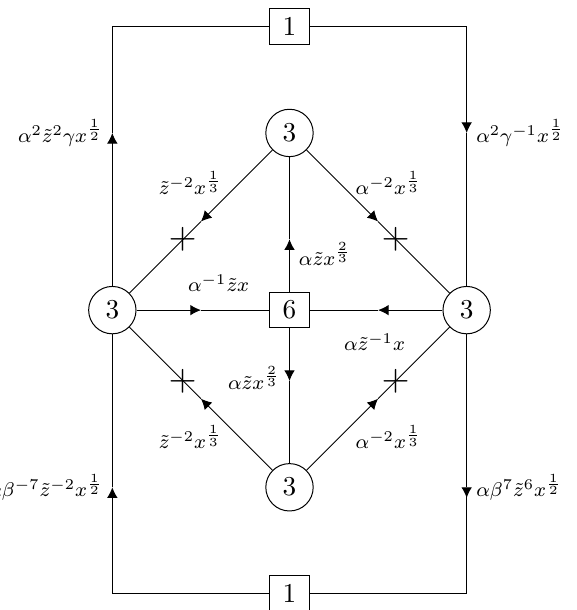
Figure 21 . The quiver for the theory resulting from the compactification of the 5 d SU(10) SCFT on a torus with flux (1 , − 1 , − 1 , − 1 , 0 , . · · · , 0)